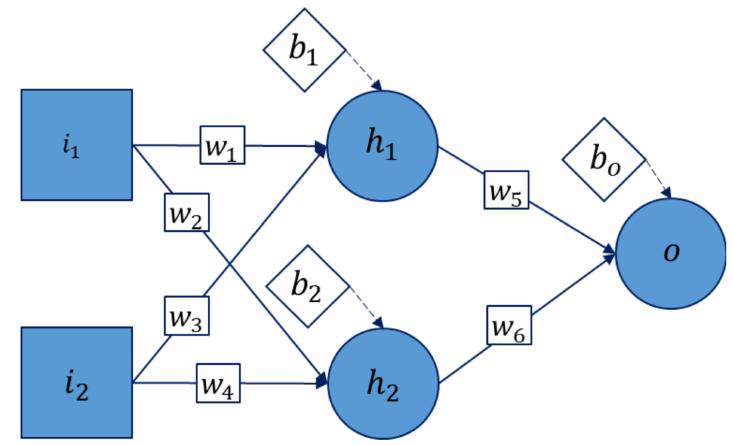
Figure 4. A simple multilayer feedforward neural